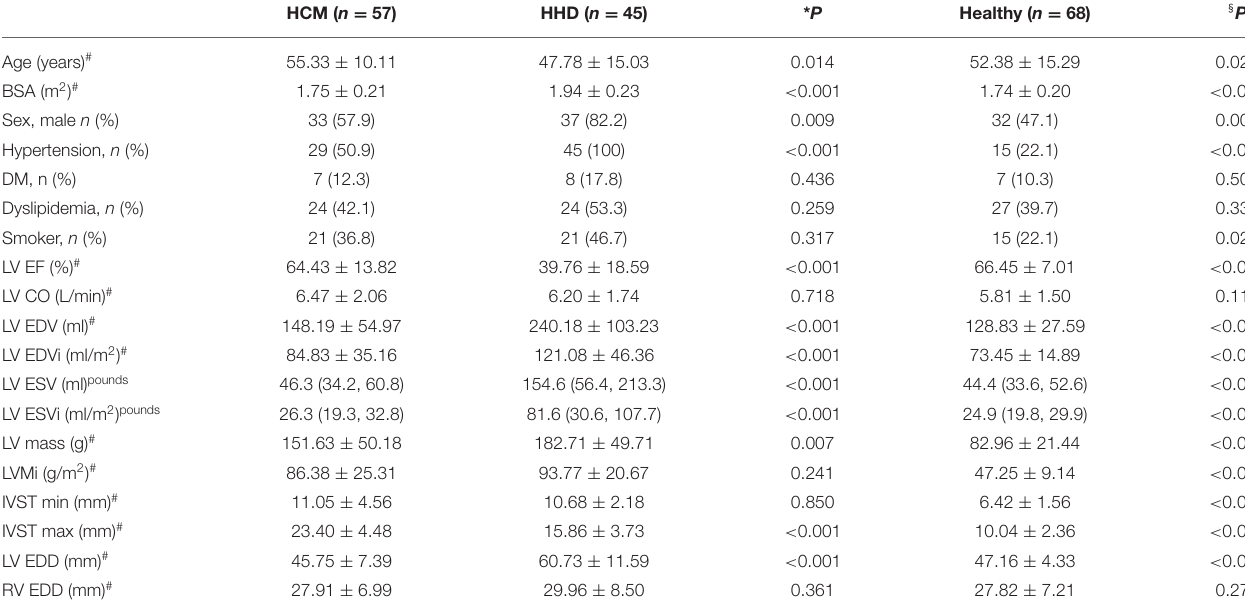
TABLE 1 | Demographic data and baseline characteristics of the study